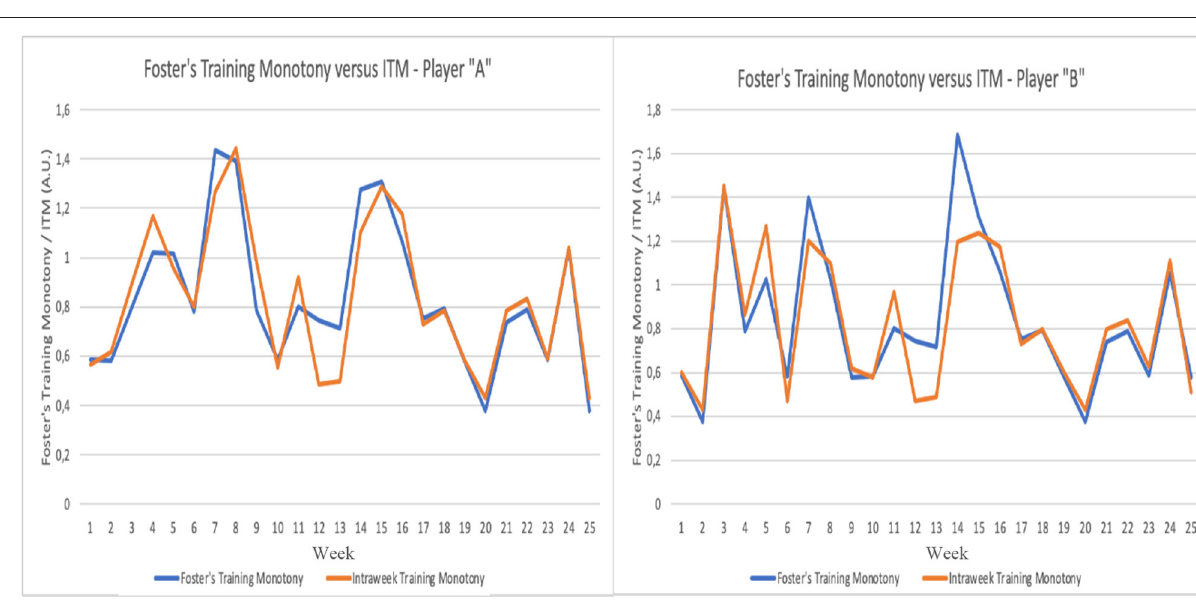
performed only one session, but with very high total